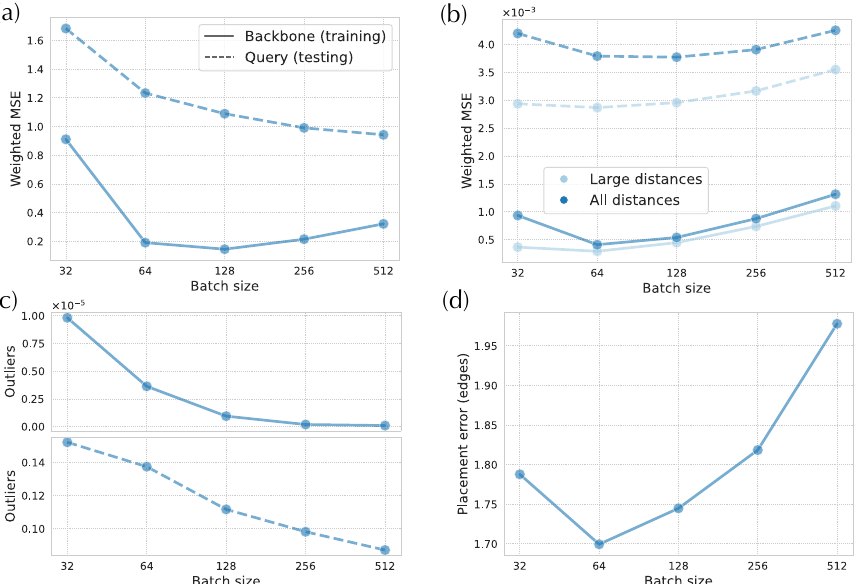
Figure 7. Impact of batch size on 16S data. ( a ) Weighted MSE for small distances. ( b ) Weighted MSE for large distances and all distances. ( c ) Proportion of outliers among distances between pair of back- bone species ( top ) and distances between query and backbone species ( bottom ). ( d ) Placement